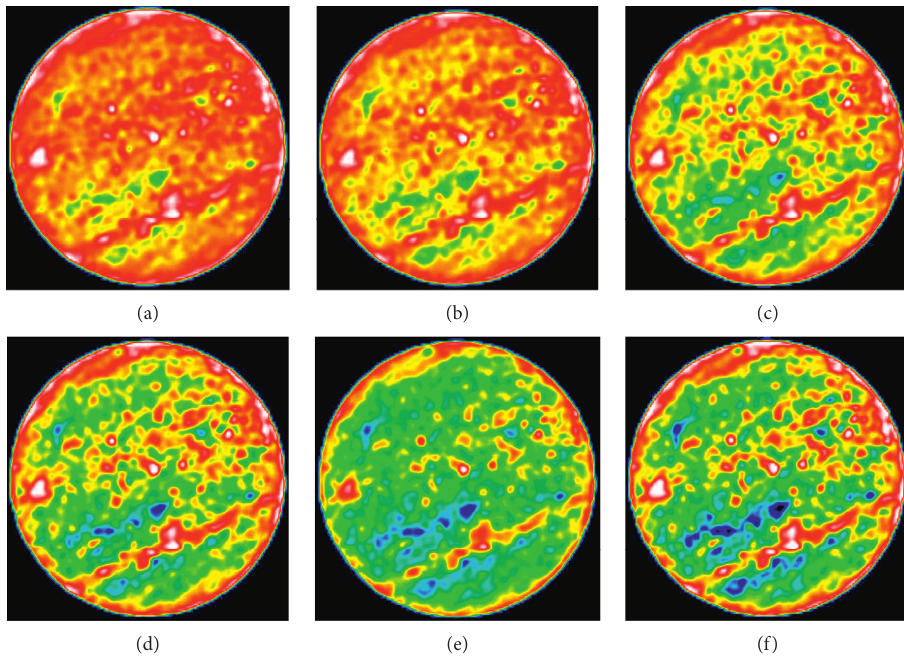
Figure 9: Pseudo-color-enhancement of CT images of the 10 th slice of sample A1 after freeze-thaw cycles. (a) 0 cycles. (b) 20 cycles. (c) 40 cycles. (d) 60 cycles. (e) 80 cycles. (f) 100